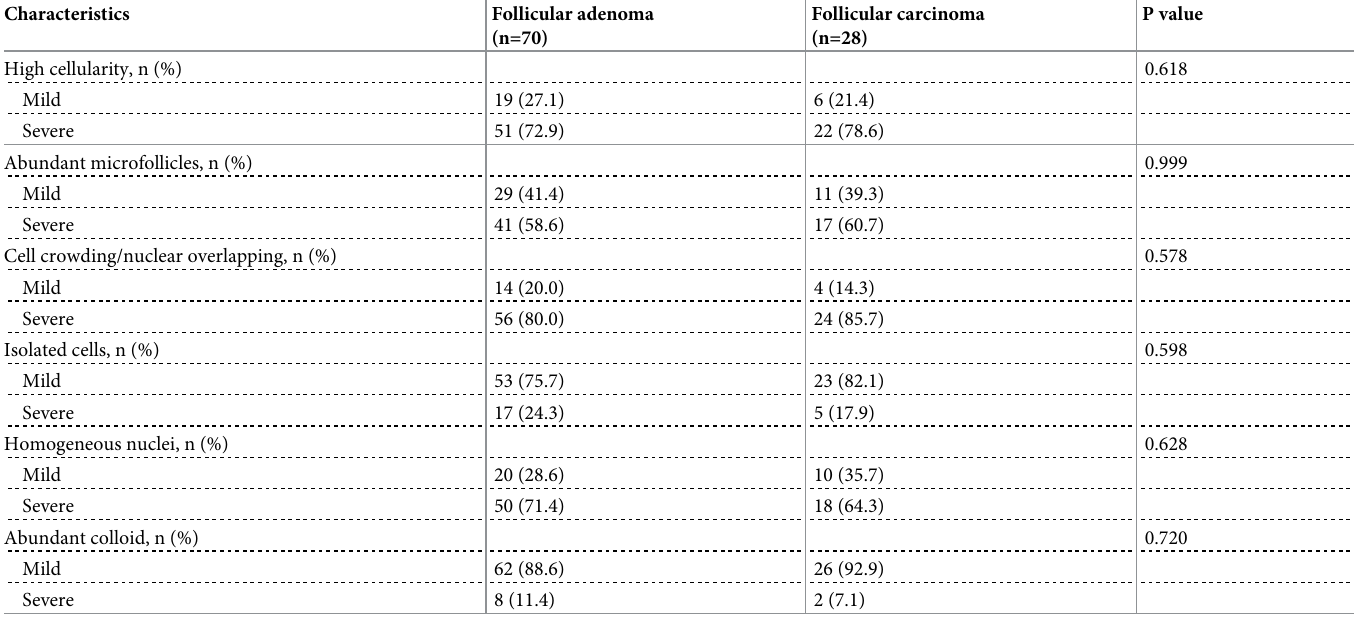
homogeneous nuclei and lack of isolated cells and abundant colloid. There were no significant differences in cytologic features between the follicular neoplasms (all p > 0.05) (Table 2). Meanwhile, there were distinct sonographic features between the two follicular neoplasms. Heterogeneous echogenicity was more common in follicular carcinomas (28.6% vs. 11.4%, p = 0.042). Follicular carcinomas also more frequently showed an ill-defined margin (14.3% vs. 2.9%), whereas follicular adenomas more commonly had a smooth margin (97.1% vs. 82.1%) (p = 0.027). Calcifications were also more common in follicular carcinomas (35.7% vs. Table 2. Cytologic features correlated with the final diagnoses of thyroid nodules.